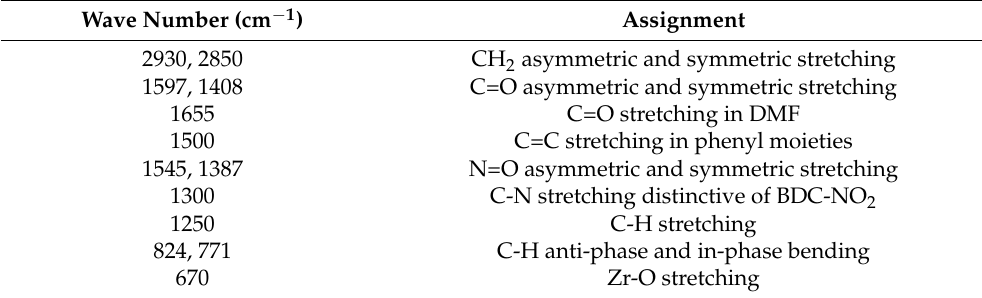
Table 2. Assignments of the FTIR peaks of UiO-66-NO 2 -X.